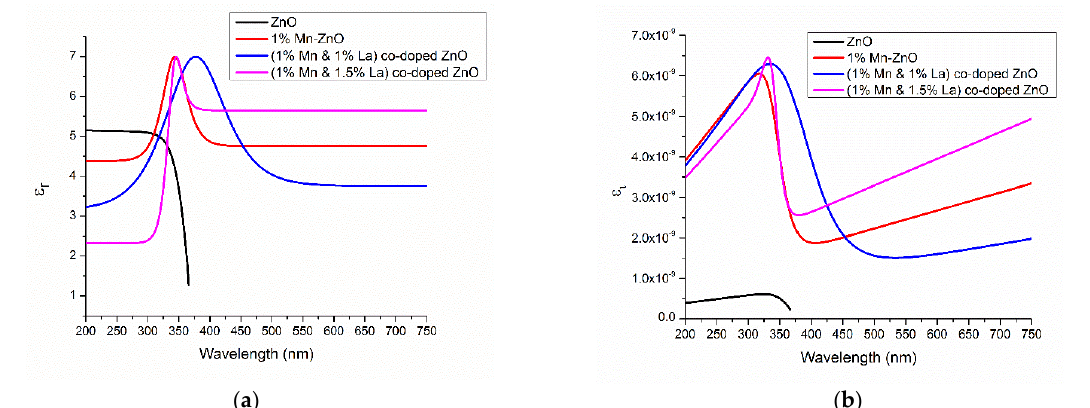
Figure 10. Dielectric constants of ( a ) Ɛ r and ( b ) Ɛ i of different samples.